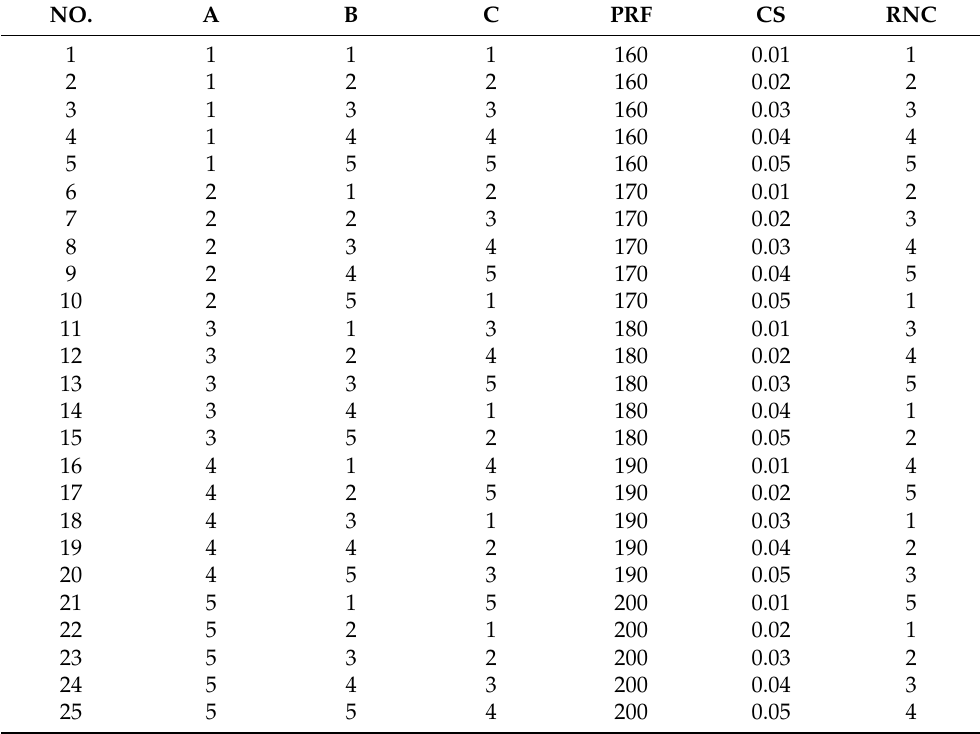
Table 3. L 25 (5 3 ) orthogonal